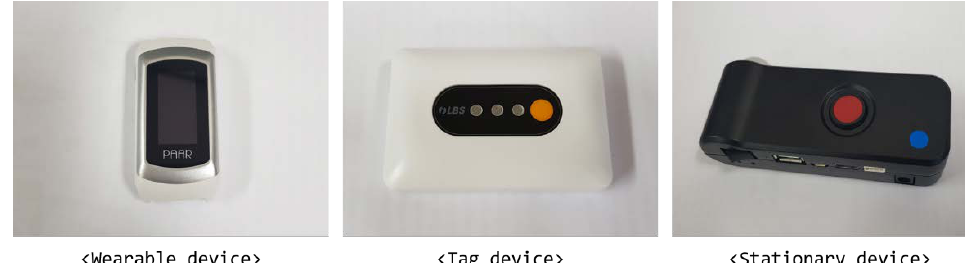
Figure 6. Implementation of the three types of portable devices.